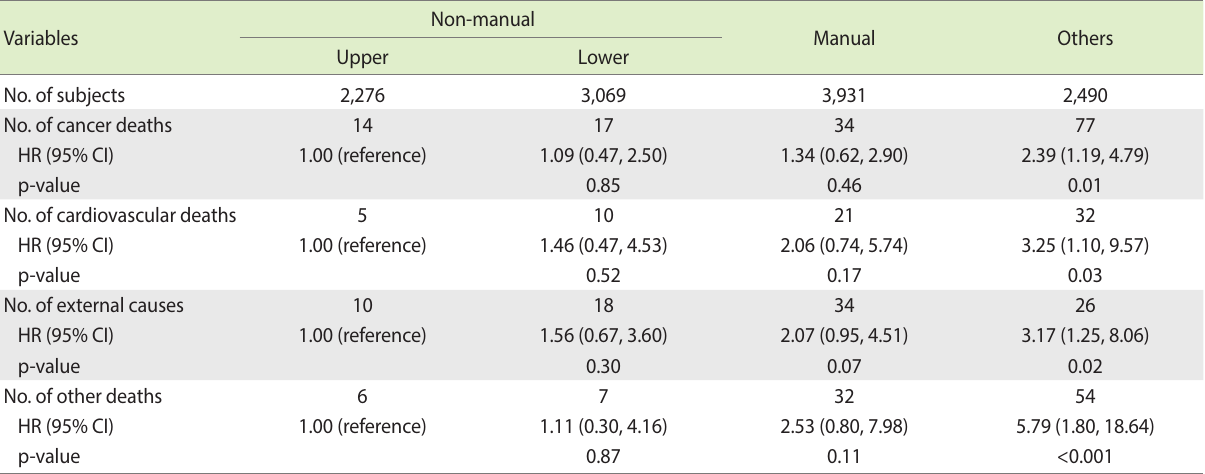
Table 2. Age-adjusted HRs and their 95% CIs for mortality 1 from 4 broad causes by occupational class in Korean males aged 35 to 64